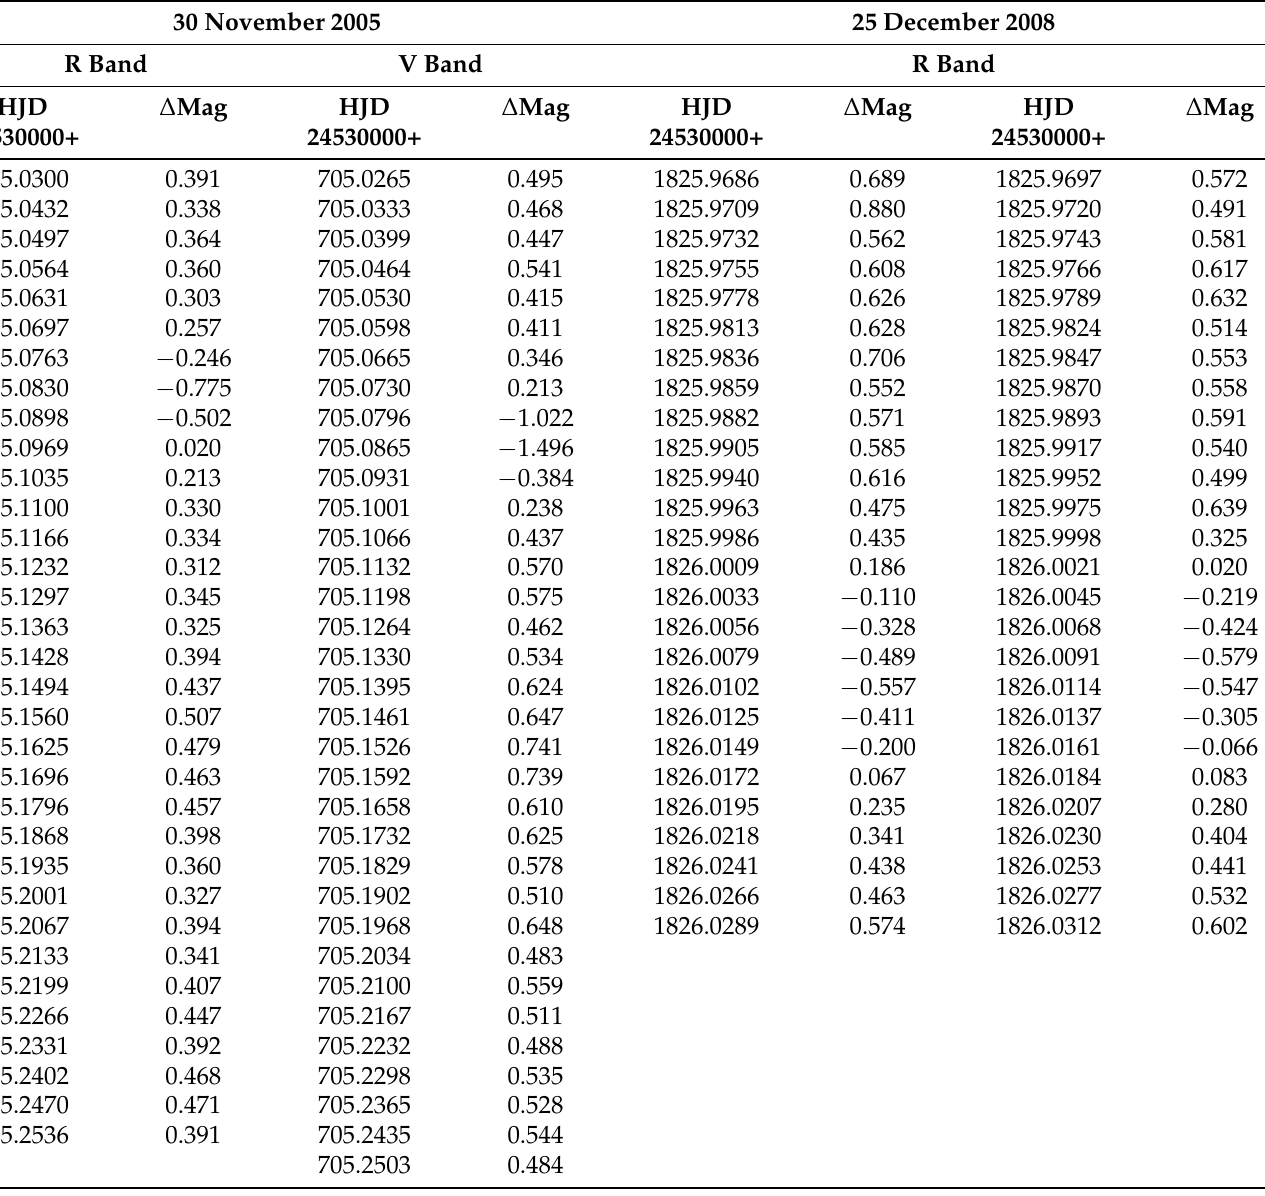
Figure A1. Three differential light curves of RW Tri in R and V bands. The error bars indicate the standard deviation (STD) of the magnitude difference between the comparison and check stars. Table A1. The ground-based photometry data of RW